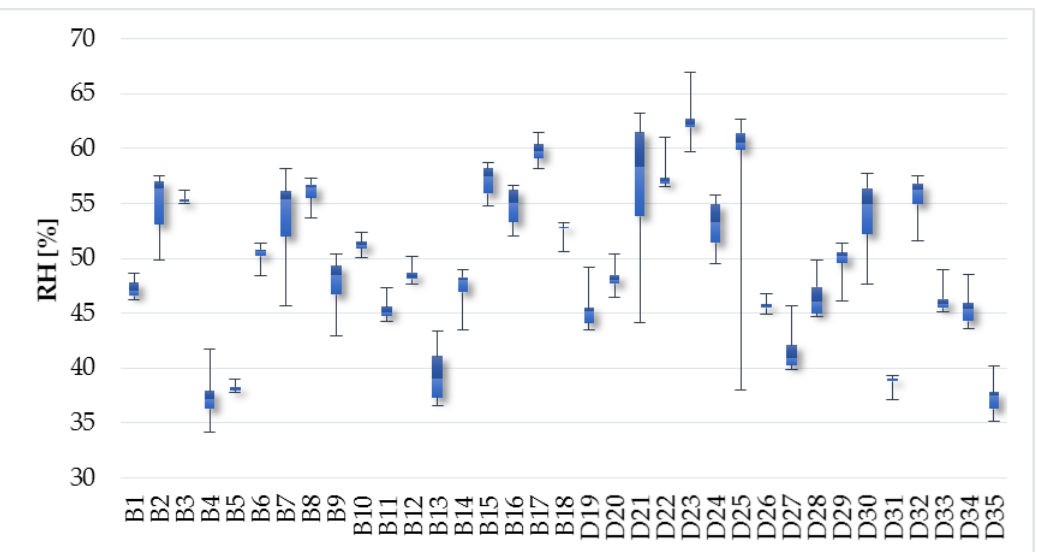
Figure 6. Relative humidity.